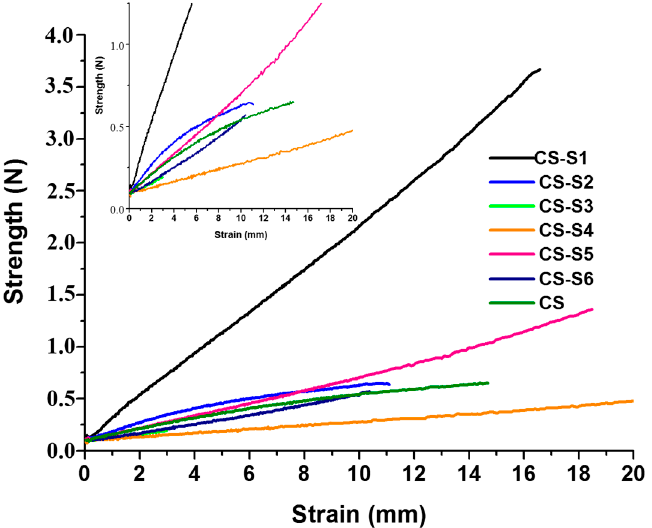
Figure 5. The strain (mm) of chitosan (CS) and chitosan-derivative films.